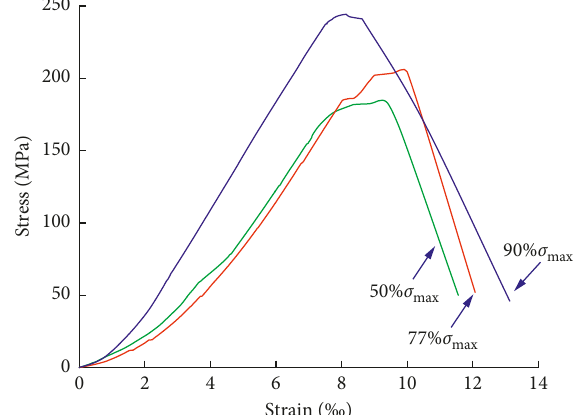
Figure 17: The axial stress-strain curve of the tested specimens under different support failure